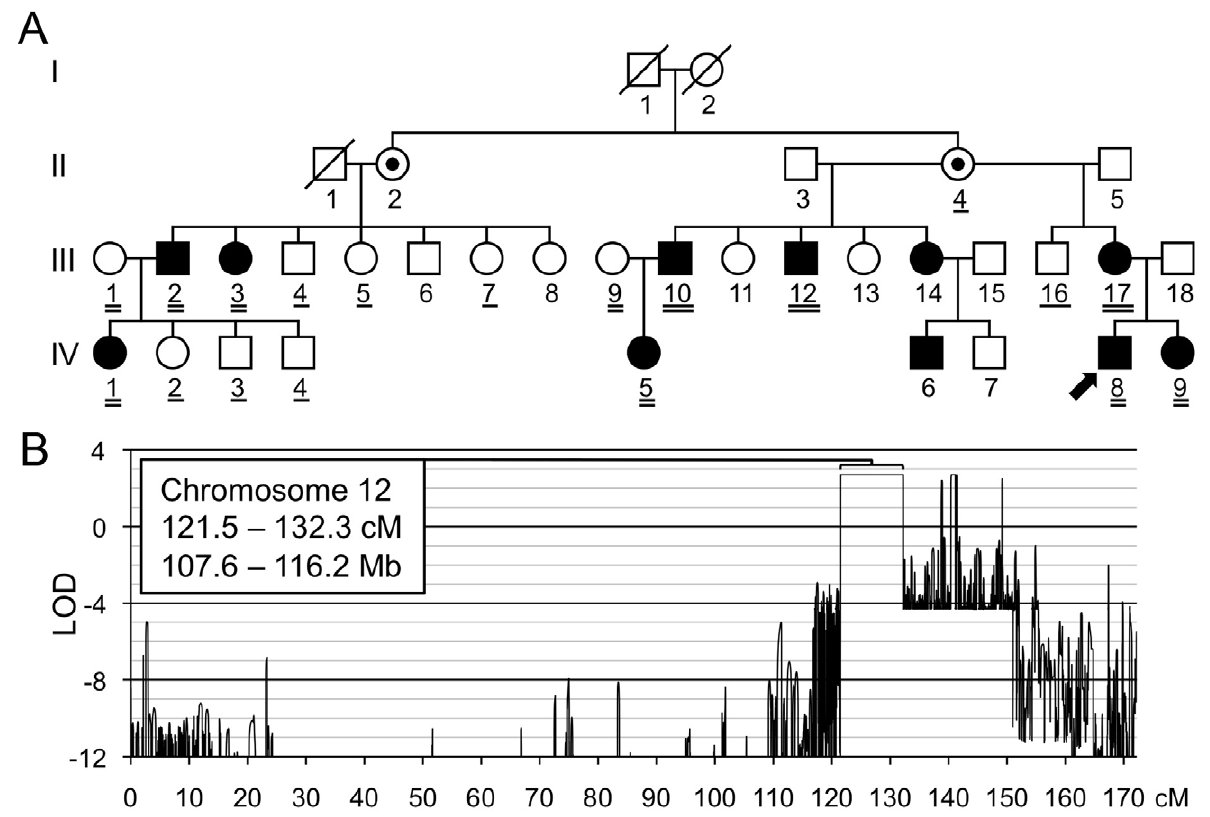
Figure 2. Linkage mapping of metachondromatosis to chromosome 12q. (A) Pedigree of the family (Family A) used to define the metachondromatosis candidate interval. Affected individuals have filled symbols. Individuals who were not examined but who were assumed to be obligate carriers have interior dots. An arrow identifies the proband. Participants whose DNA was used for linkage analysis are double underlined. Those participants with a single or double underlines were tested for the PTPN11 mutation, after the mutation had been identified in participants A- III-10 and A-IV-5 by targeted array capture and Illumina sequencing. (B) LOD score plot of chromosome 12. Only one interval, larger than 1 cM, in the entire genome attained the maximum LOD score of 2.7. Several autosomal intervals, each smaller than 1 cM, also achieved maximum or positive LOD scores (Figure S1). These likely represent either genotyping errors or short ancestral haplotypes that are coincidental with linkage. The physical coordinates shown are derived from GRCh37/hg19.